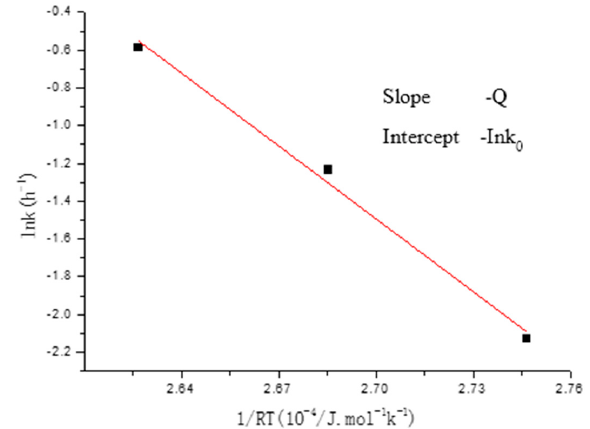
Figure 4. Relationship between Ink and 1/ RT .